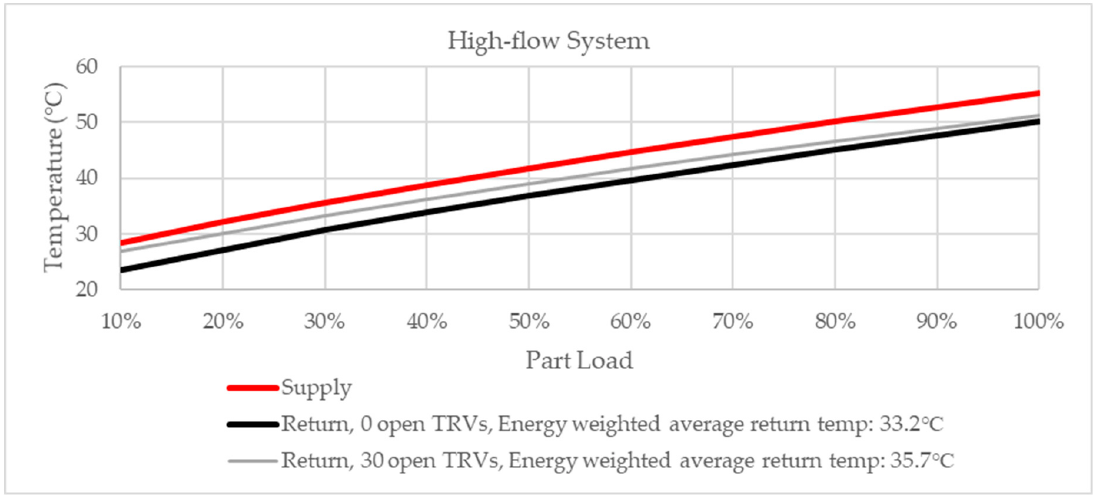
Figure 10. The calculated optimal supply temperature and the return temperature results from the analysis for the operation without problematic TRVs and with one problematic TRV in each riser under high-flow system operation.